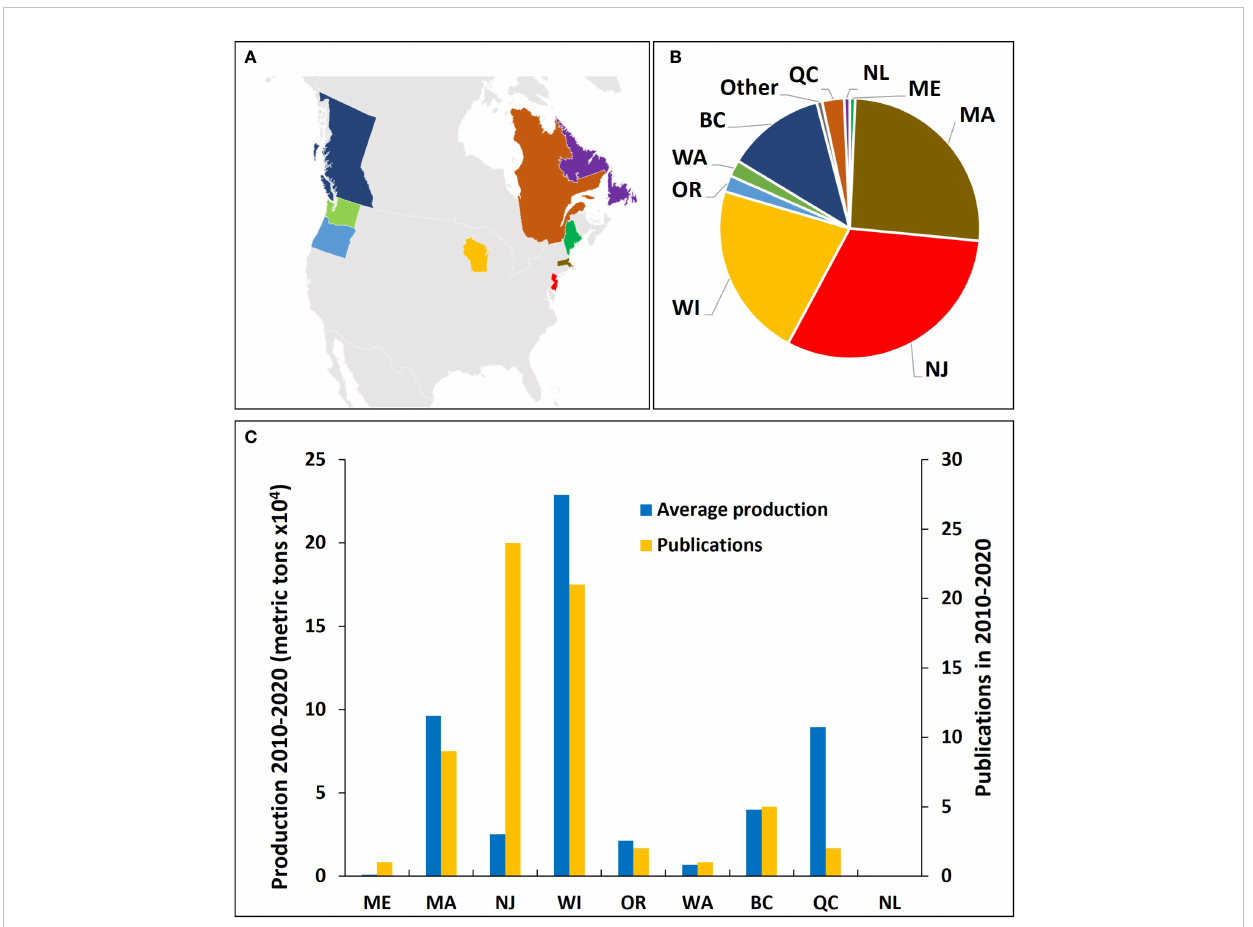
FIGURE 5 Regions in North America where most scienti fi c publications about cranberry entomology topics have been conducted (A) , and proportion of scienti fi c publications by region (B) from 1990 to 2021. Publication counts compared to average production in the years 2010 to 2020 (C) . US states: WI, Wisconsin; MA, Massachusetts; NJ, New Jersey; OR, Oregon; WA, Washington; ME, Maine. Canadian provinces: BC, British Columbia; QC, Que ́ bec; NL, Newfoundland and Labrador. Data obtained from USDA NASS (2022) and Statistics Canada